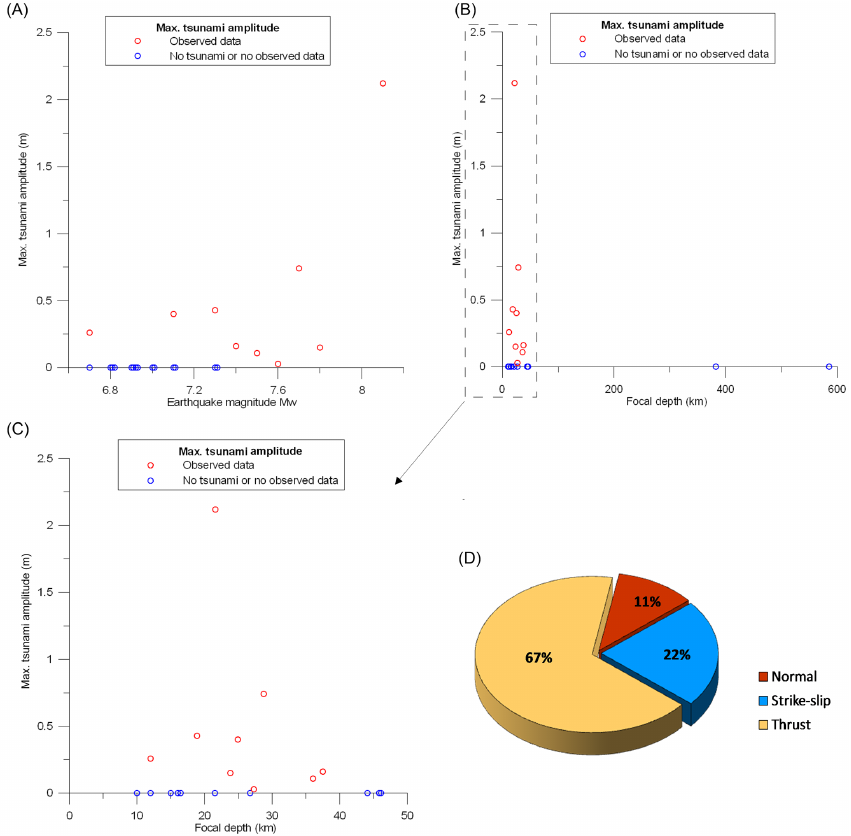
Figure 10. (a) Observed tsunami wave amplitudes for the various magnitudes of the analyzed earthquakes; (b) observed tsunami wave amplitudes for the different depths of the analyzed events; (c) zoom on the depth region from 0–50km and the corresponding observed tsunami wave amplitudes; (d) proportions of mechanism focal types for the earthquake events that caused